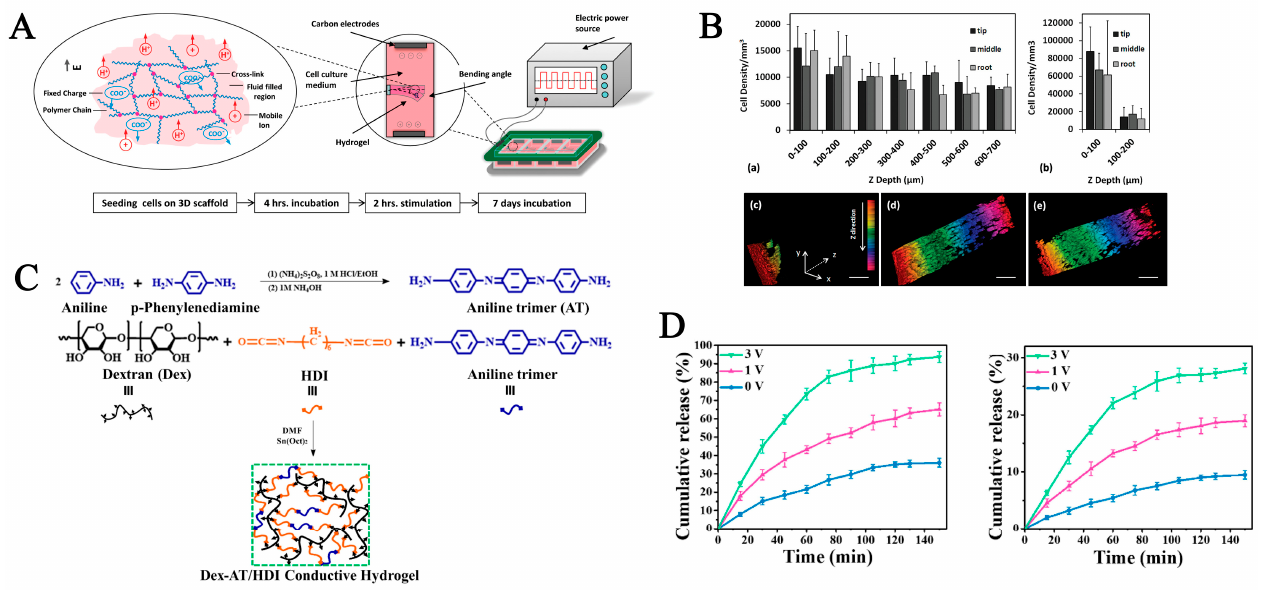
Figure 10. ( A ) Schematic of polyelectrolyte hydrogel bending when electrical stimulation is per- formed; the hydrogel shrinks at the anode and expands at the cathode. ( B ) Cell distribution in the hydrogels under stimulated condition or unstimulated condition. The distribution of pSMCs in PAA/fibrin hydrogels under stimulated condition by electrical field ( a ) or non-stimulated condition ( b ) in the long axis of the gel with a distinction in three regions. ( c ) No electric field was applied. ( d ) Electrical stimulation without verapamil addition or ( e ) with verapamil treatment. Reprinted with permission from [99]. ( C ) Schematic of aniline trimer (AT) and Dex-AT/HDI hydrogel. ( D ) Drug release of dexamethasone and indomethacin in phosphate buffer pH = 7.4 at different electric potentials. Reprinted with permission from [100].